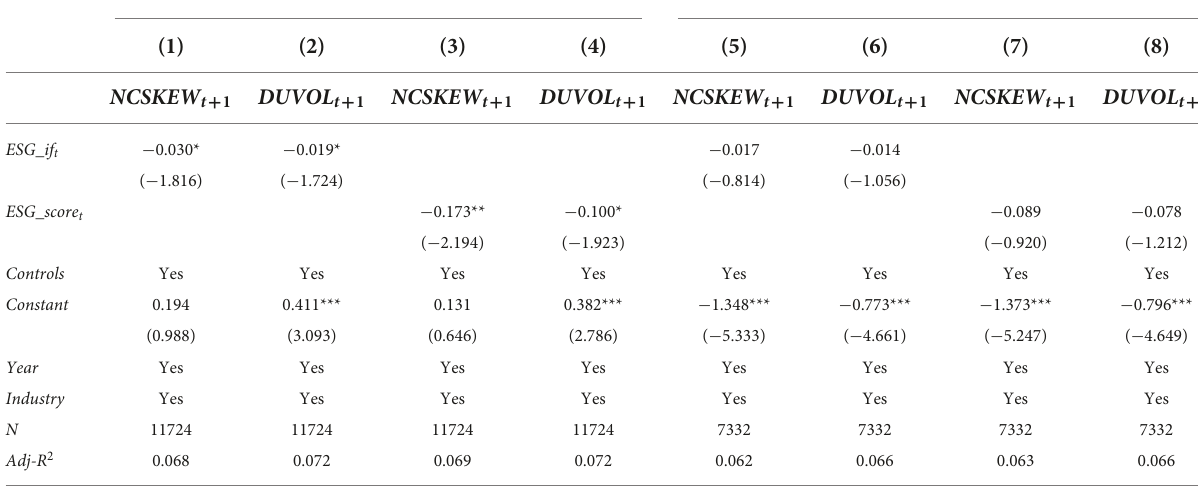
TABLE 6 Capital market